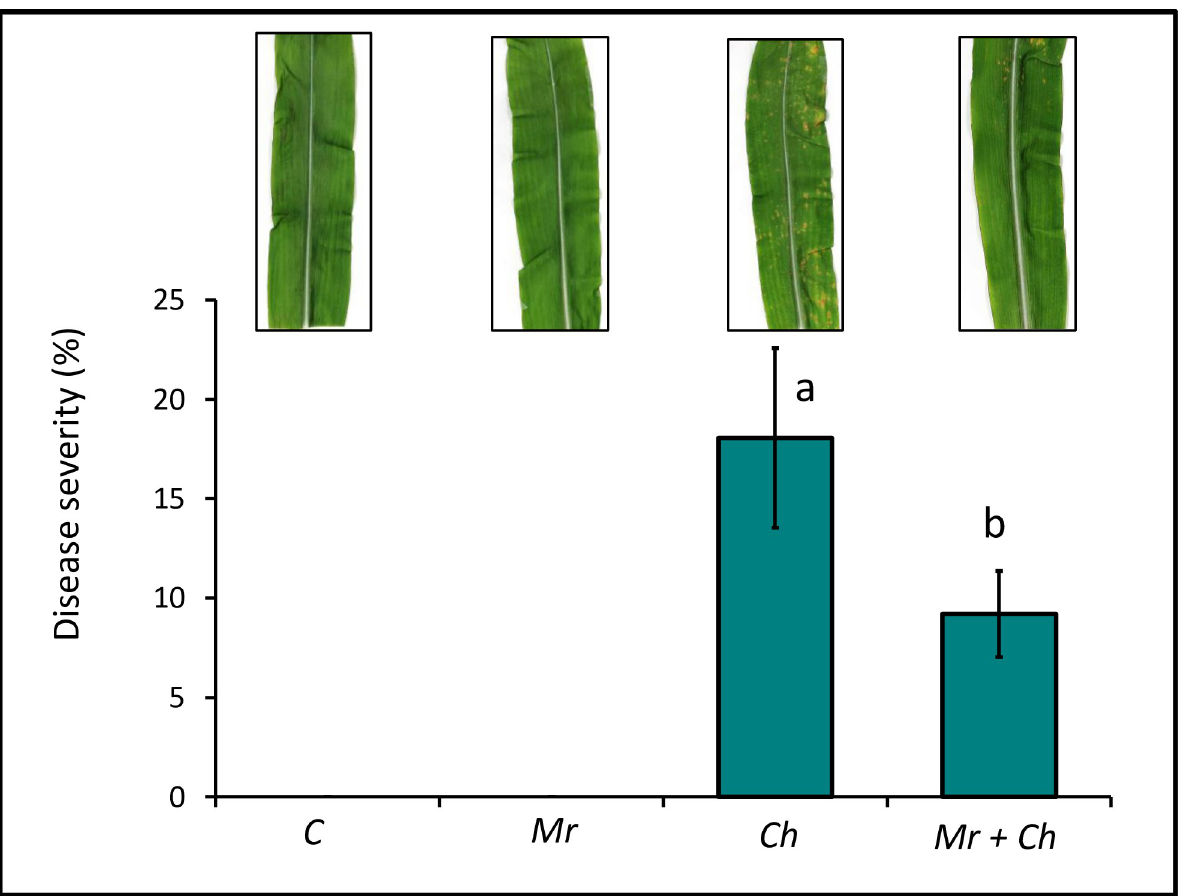
Fig 3. Area of diseased leaf tissue in V4 maize. End-of-experiment mean percentage of diseased maize leaf area in the M . robertsii (Mr), C . heterostrophus (Ch), M . robertsii + C . heterostrophus (Mr + Ch) treatments and untreated control (C) ( F 3,65 = 118; P < 0.0001). Values are untransformed means ± SEM; different letters indicate significant differences at α =